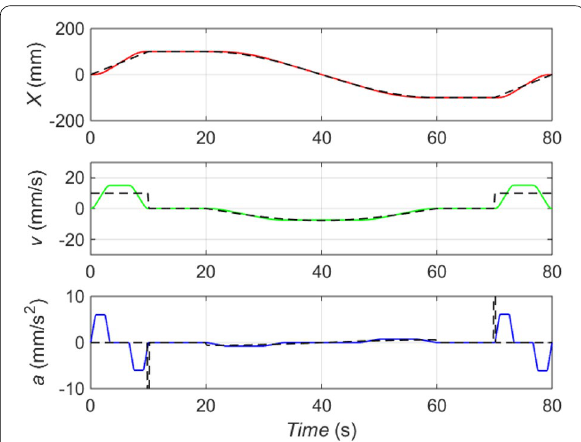
Figure 13 Position, velocity, and acceleration curves of double-S velocity curve planning in the X direction